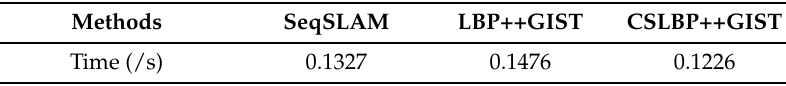
Table 2. Comparison of average describing times for each image (/s).